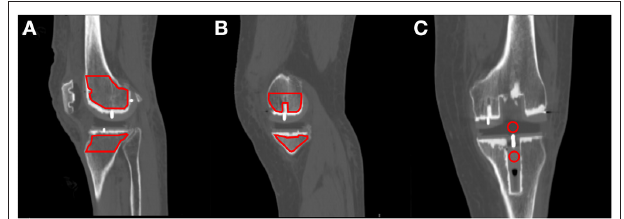
FIGURE 5 | The CT density measurement method. In the sagittal position, the lateral and medial condyles were selected centrally (midpoint of the metal alignment line), and the cancellous area was encircled using the Weasis polygon tool (A,B) . The HU values of the HXLPE bearing and the PEEK tibial prosthesis stem (stem) were selected in the coronal position (C) . The ROI is distributed up to the highest area of the femoral prosthesis to the joint line a, and the lowest area of the tibial plateau is visible on CT to the joint line. CT, computed tomography; HU, Hounsfield unit; HXLPE, highly